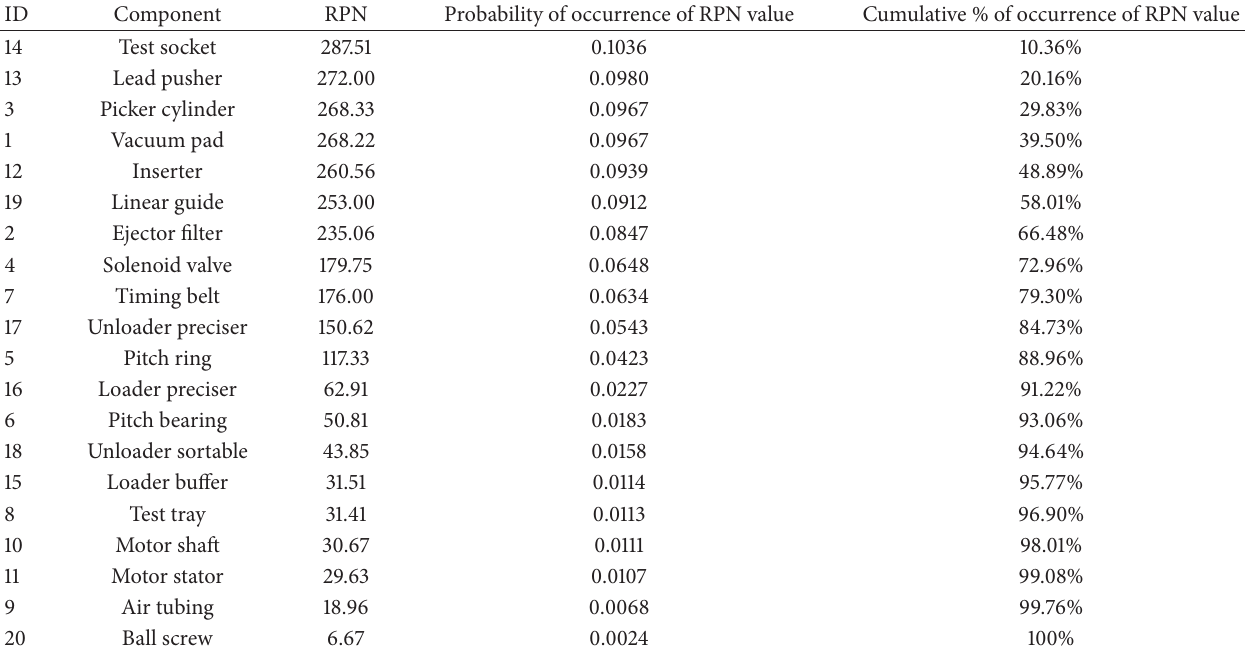
Table 5: Cumulative percentage of occurrence of RPN values.